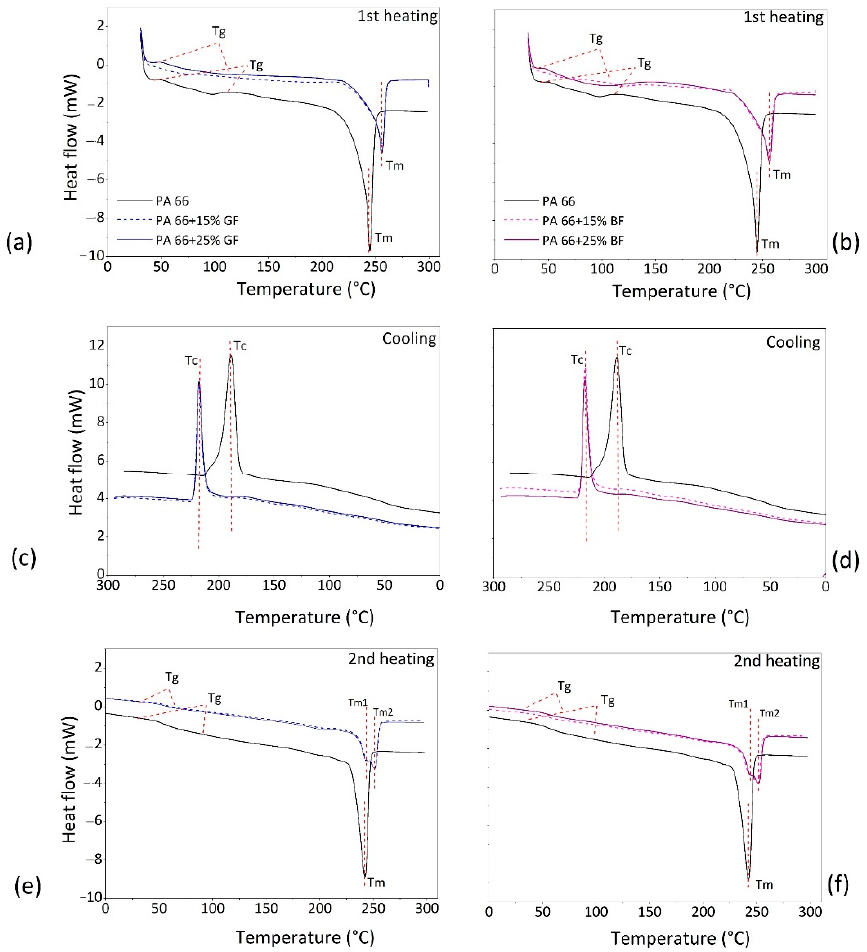
Figure 4. Heat flow curves as a function of temperature recorded during DSC thermal cycles for developed composites (legend in ( c , e ) as in ( a ), legend in ( d , f ) as in ( b )).